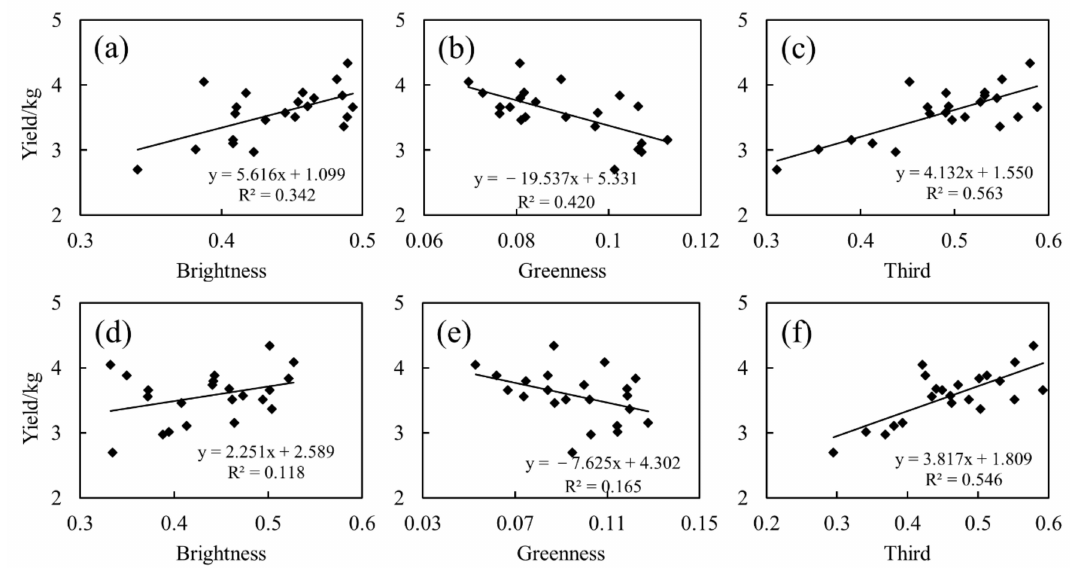
Figure 6. Fitting of TCT parameters to yield at different growth stages: ( a – c ) booting stage; ( d – f ) heading